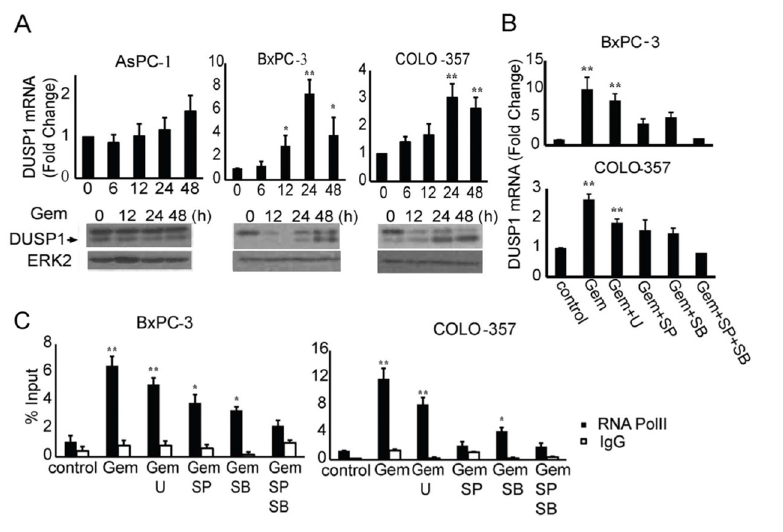
Fig 2. Gemcitabine induces DUSP1 transcription through JNK and p38 MAPK signaling. (A) AsPC-1, BxPC-3, and COLO-357 cells were incubated for the indicated times with 100 ng/ml, 10 ng/ml, and 5 ng/ml gemcitabine, respectively, and DUSP1 levels were assessed by Q-PCR. Additionally, immunoblotting of cell lysates from AsPC-1, BxPC-3, and COLO-357 cells that were incubated for the indicated times with 100 ng/ml, 10 ng/ml, and 5 or 10 ng/ml gemcitabine, respectively, revealed that gemcitabine increased DUSP1 protein levels in BxPC-3 and COLO-357 cells, but not in AsPC-1 cells. In the example shown COLO-357 cells were incubated with 10 ng/ml gemcitabine. (B,C) BxPC-3 and COLO-357 cells were incubated for 24 h with 10 ng/ml and 5 ng/ml gemcitabine, respectively, in the absence or presence of 10 μ mol/L U0126, 10 μ mol/L SP600125, 10 μ mol/L SB203580, or both SP600125 and SB203580, and Q-PCR (B) and RNA polymerase II ChIP followed by Q-PCR for DUSP1 gene body region (C) were performed. All RNA-related data are the means ± SEM of 3 experiments. � p < 0.05; �� p < 0.01, compared with control.